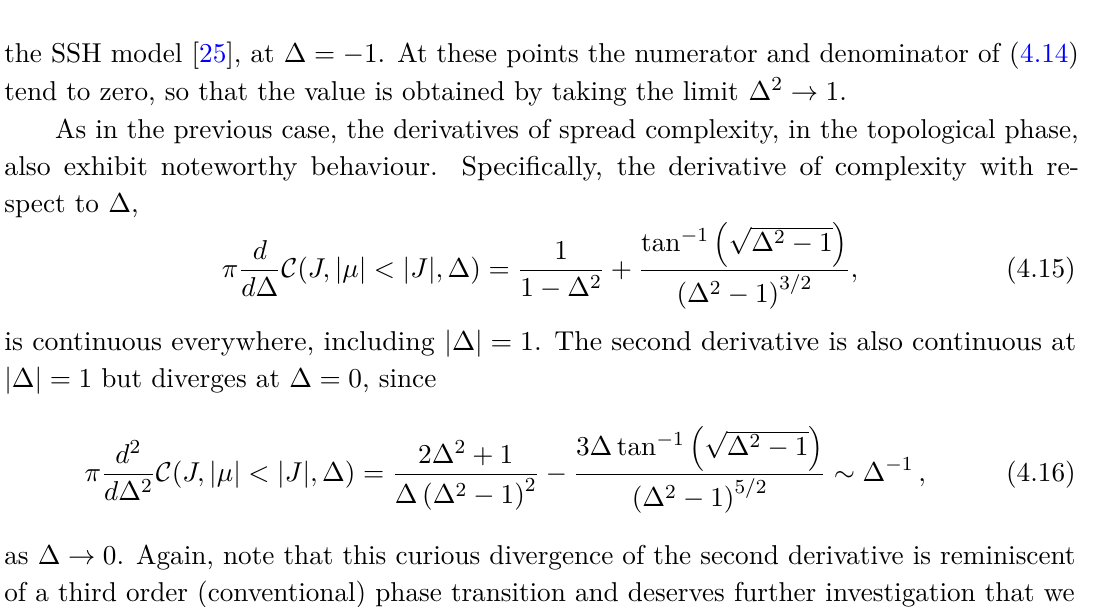
the SSH model [25], at ∆ = − 1 . At these points the numerator and denominator of (4.14) tend to zero, so that the value is obtained by taking the limit ∆ 2 → 1